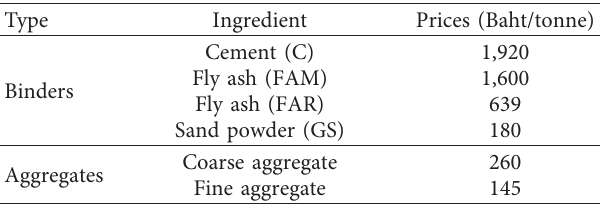
Table 8: Unit prices of concrete